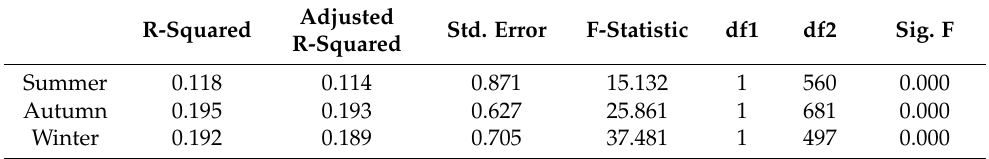
Table 6. The information of thermal comfort regression models in the summer, autumn, and winter. Adjusted Std. Error F-Statistic df1 df2 Sig. R-Squared R-Squared